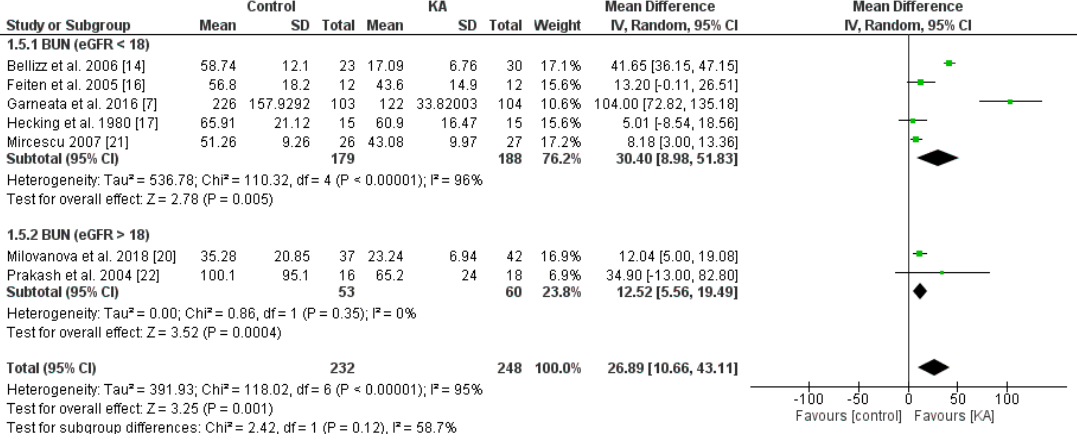
Figure 6. Forest plot of effects of KA on BUN in CKD patients sub-grouped by eGFR. The random-effects model was utilized.